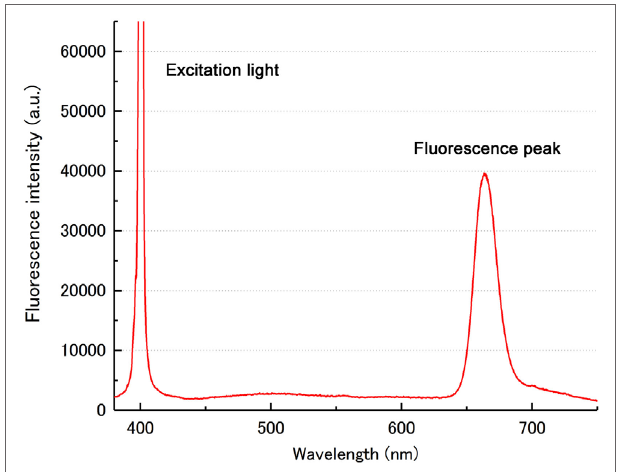
FigUre 2 | An example of a fluorescence spectrum from the CE region. A single sharp peak at 664 nm indicated the fluorescence from TS. Another peak corresponding to the 400-nm excitation light was easily distinguished from the TS peak. a.u., arbitrary units; CE, contrast-enhanced; TS, talaporfin sodium.